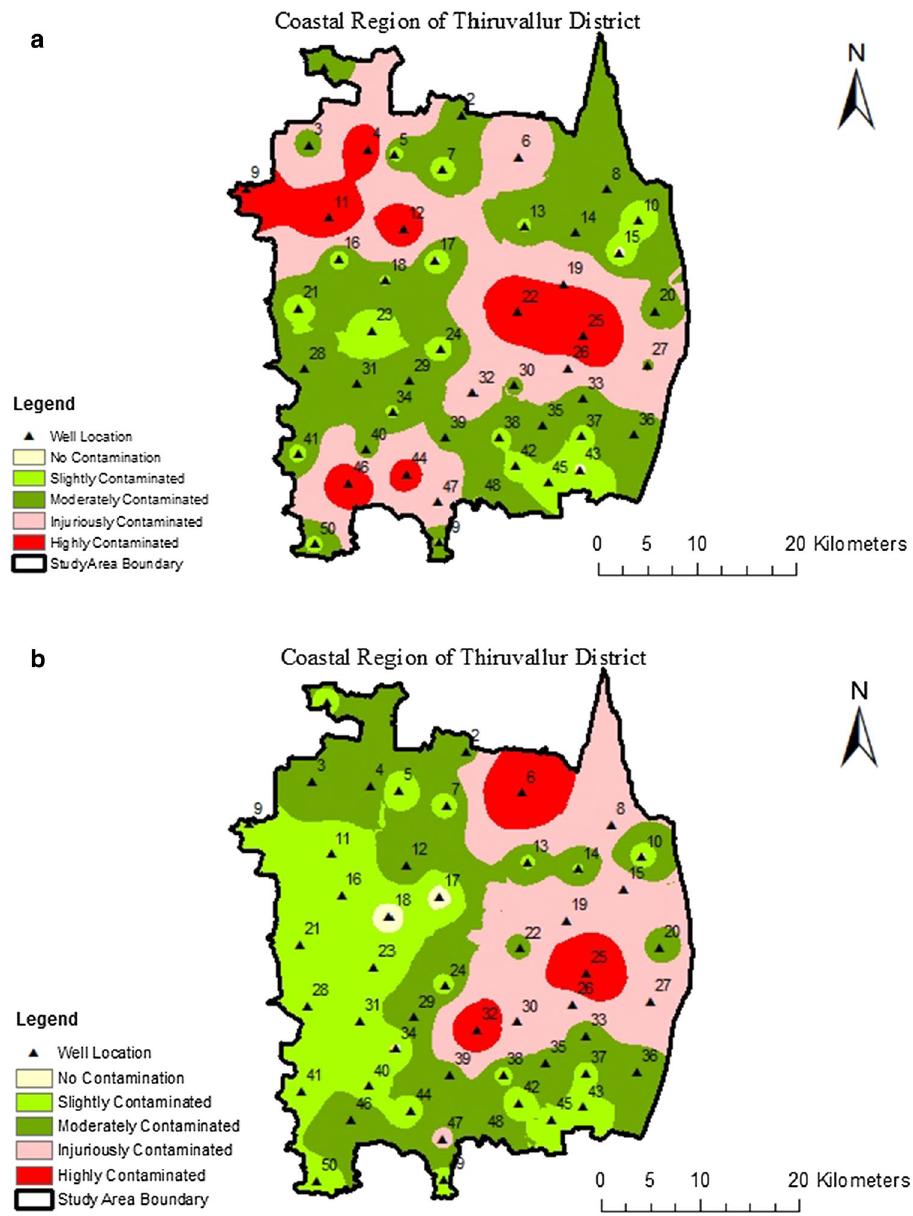
Fig. 5 Spatial variation map